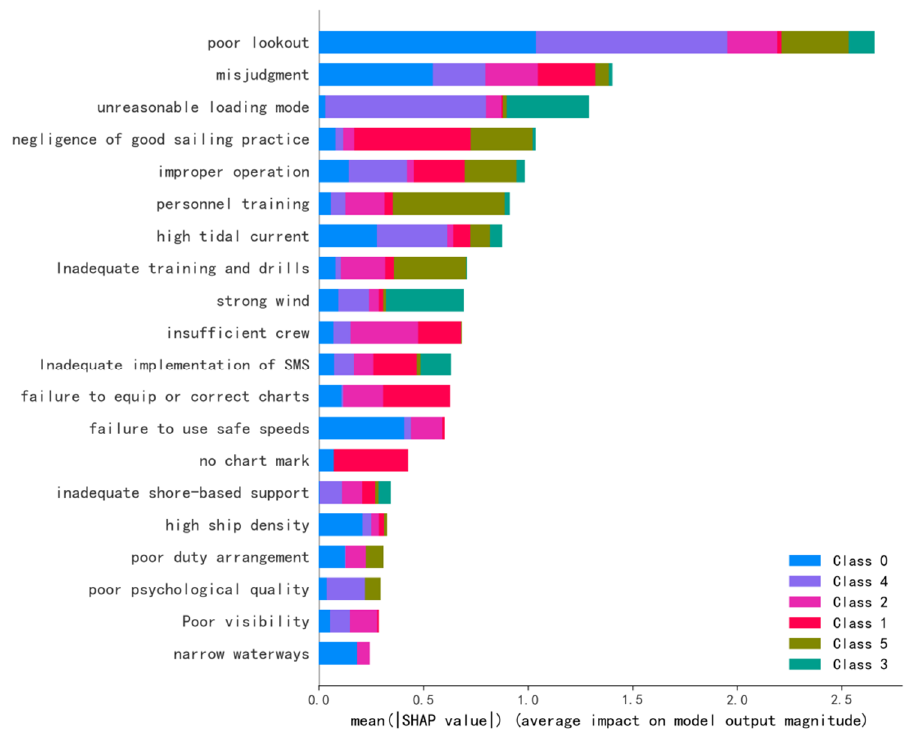
Figure 9. SHAP values of the top 20 significant eigenvalues.